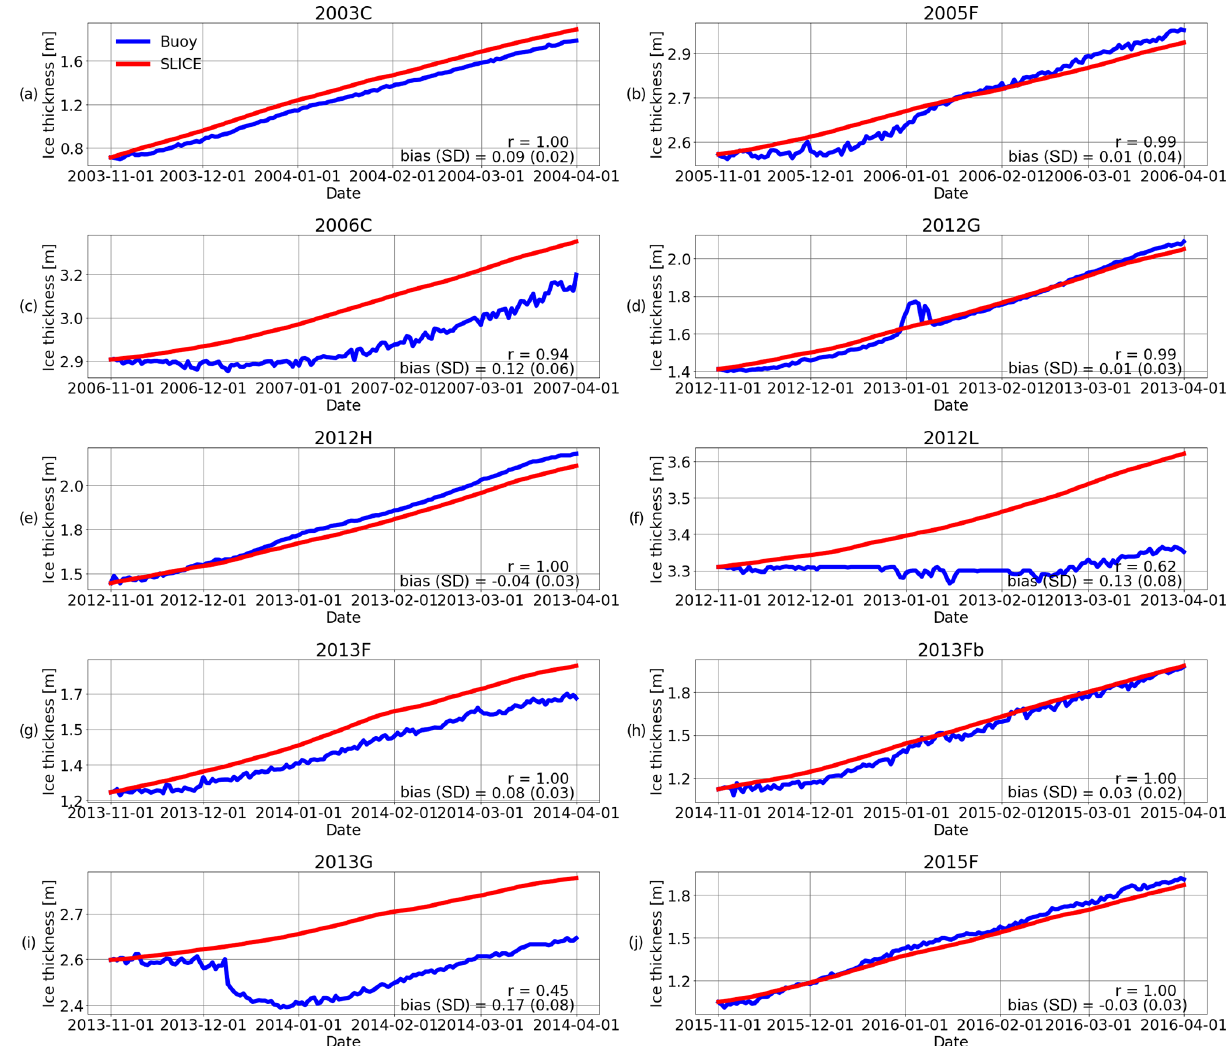
Figure 4. Ice thickness observations from ice mass balance buoys (blue) and SLICE (red) for buoys (a) 2003C, (b) 2005F, (c) 2006C, (d) 2012G, (e) 2012H, (f) 2012L, (g) 2013F, (h) 2013Fb, (i) 2013G, and (j) 2015F. Linear correlation ( r ) and bias values are listed. Across all buoys, the r values have a mean of 0.89 and the biases have a mean of